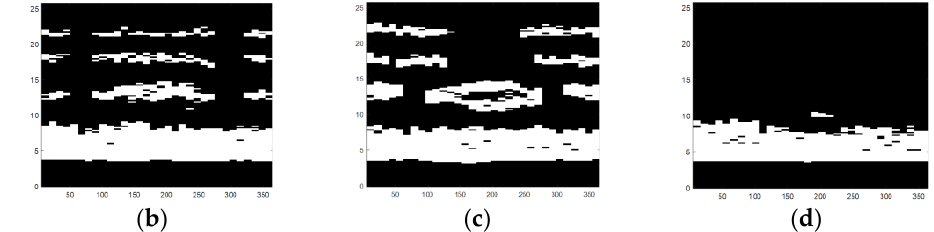
Figure 14. The defect images processed by the three-threshold maximum inter-class variance method: ( a ) small crack, ( b ) transverse crack, ( c ) hole defect, and ( d ) chapped defect.